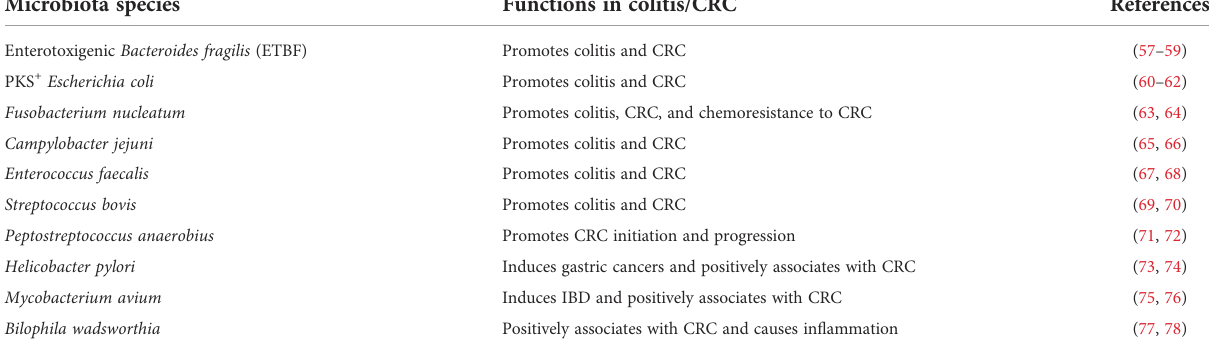
TABLE 1 Identi fi ed CRC-promoting microbiota species in preclinical/clinical